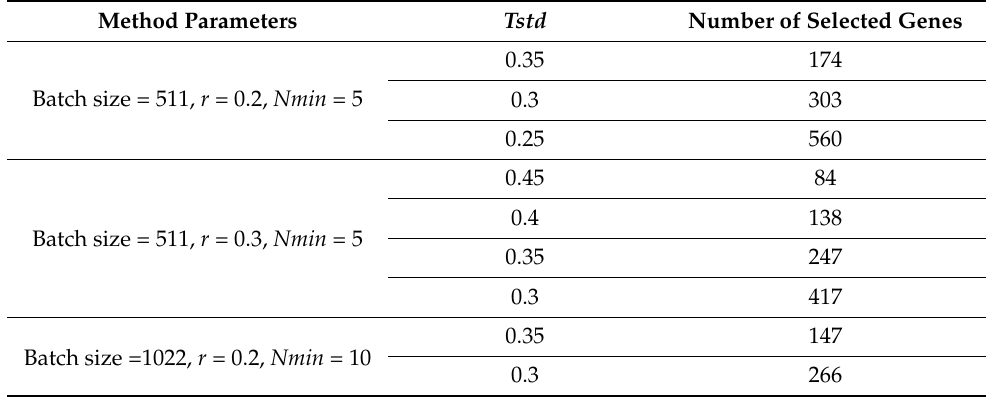
Table 3. The number of selected genes according to standard deviation